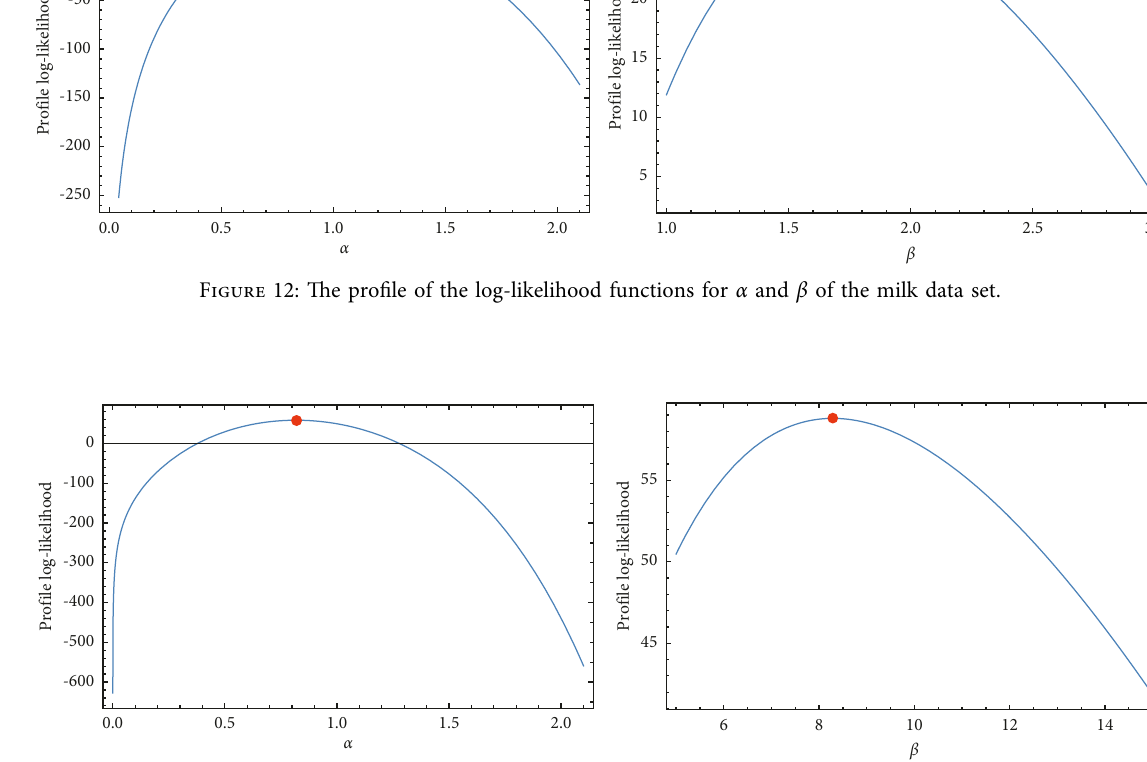
Figure 13: The profile of the log-likelihood functions for α and β of the COVID-19 data